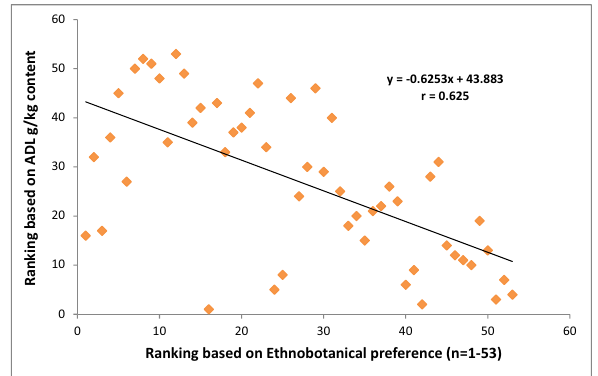
Figure 7. Negative correlation between fodder grass rankings based on ethnobotanical preference versus ranks based on ADL contents (high to low).